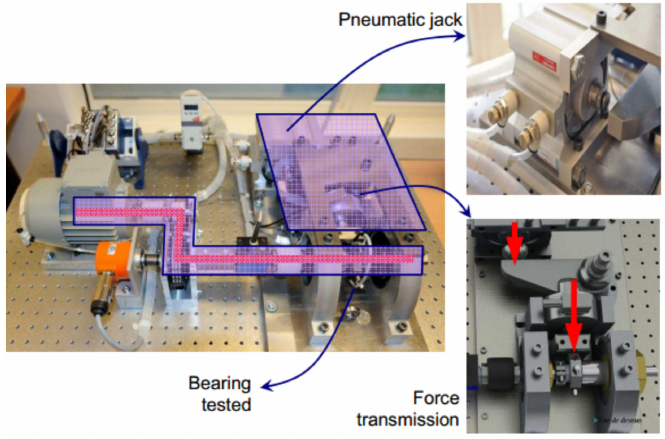
Figure 10. Test platform of PHM 2012.